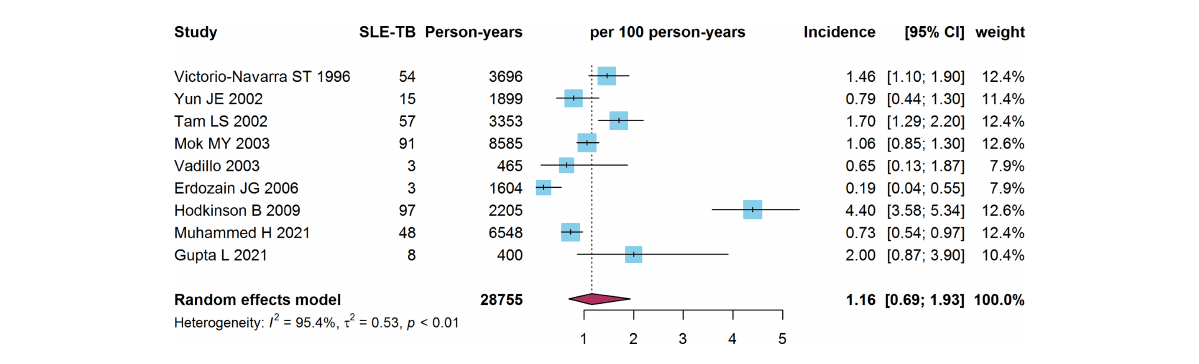
FIGURE 2 Forest plot of the SLE-TB incidence. SLE, systemic lupus erythematosus; TB, tuberculosis.